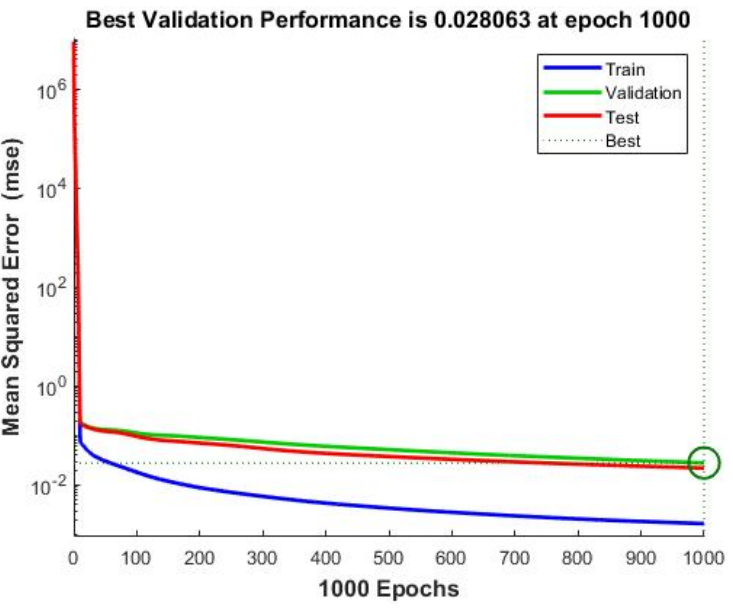
Figure 5. Best Validation Performance.